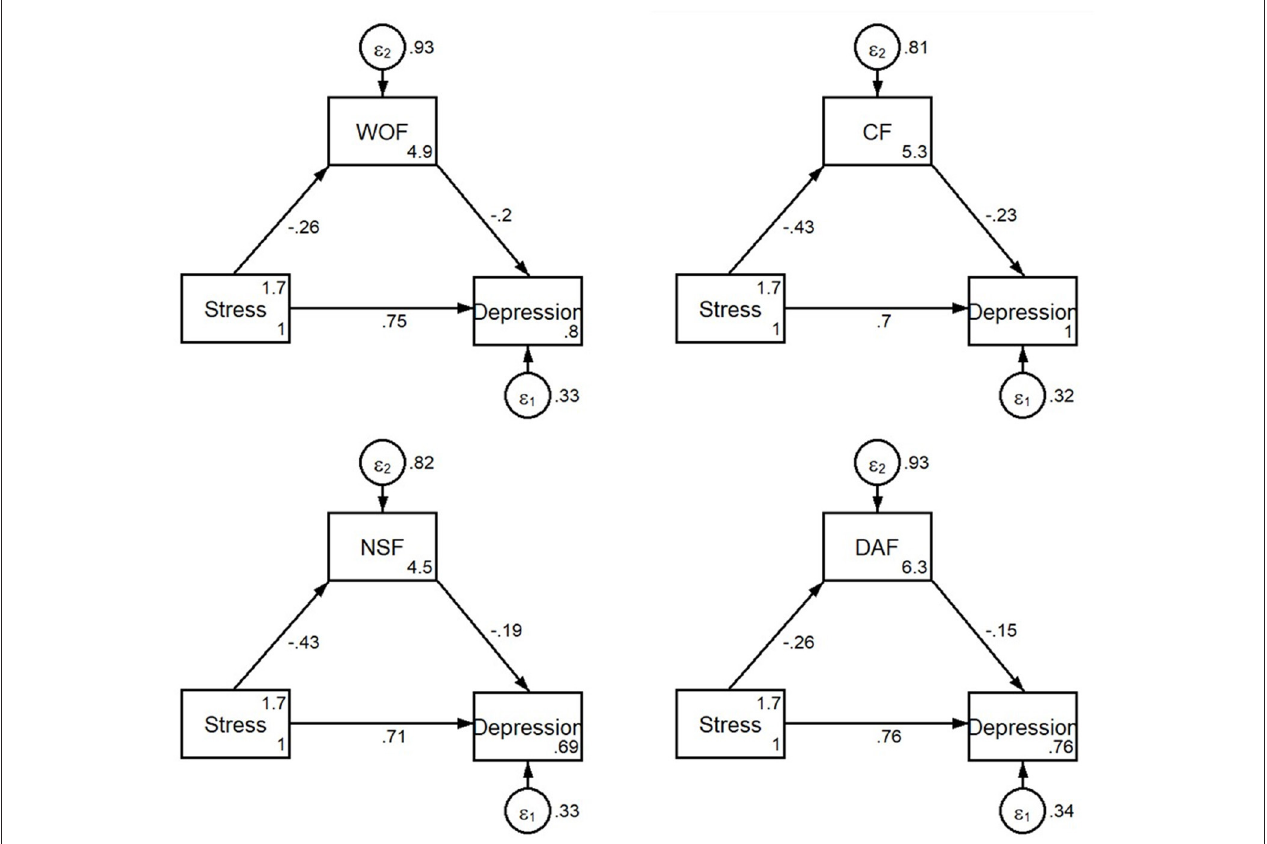
FIGURE 4 | The structural equation model on the relationship between occupational stress, depressive symptoms, WOF and WOF types among 1988 medical workers. Stress, occupational stress; Depression, depression symptoms. WOF, worker occupation fit; CF, Characteristic fit; NSF, need supply fit; DAF, demand ability